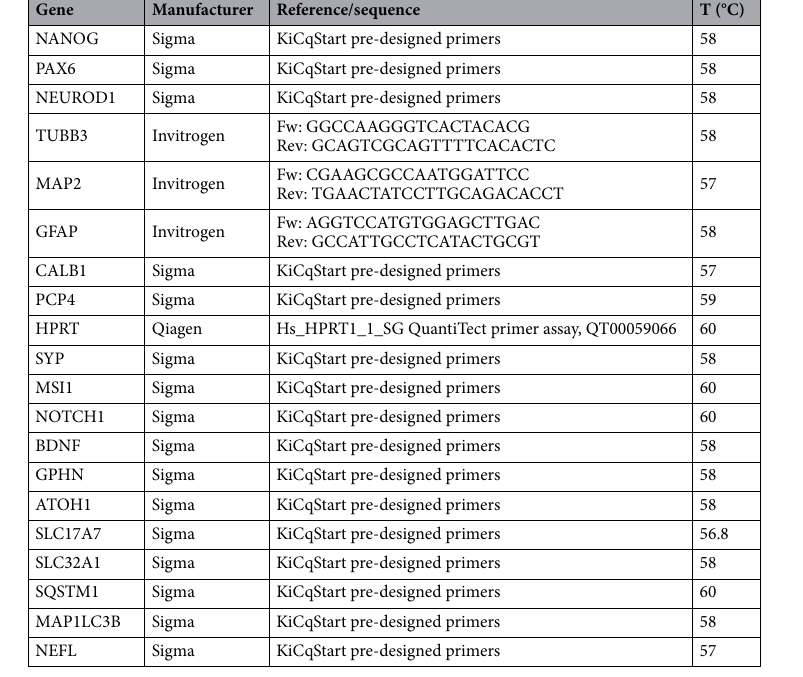
Table 2. Primers used for RT-qPCR. T (°C): annealing